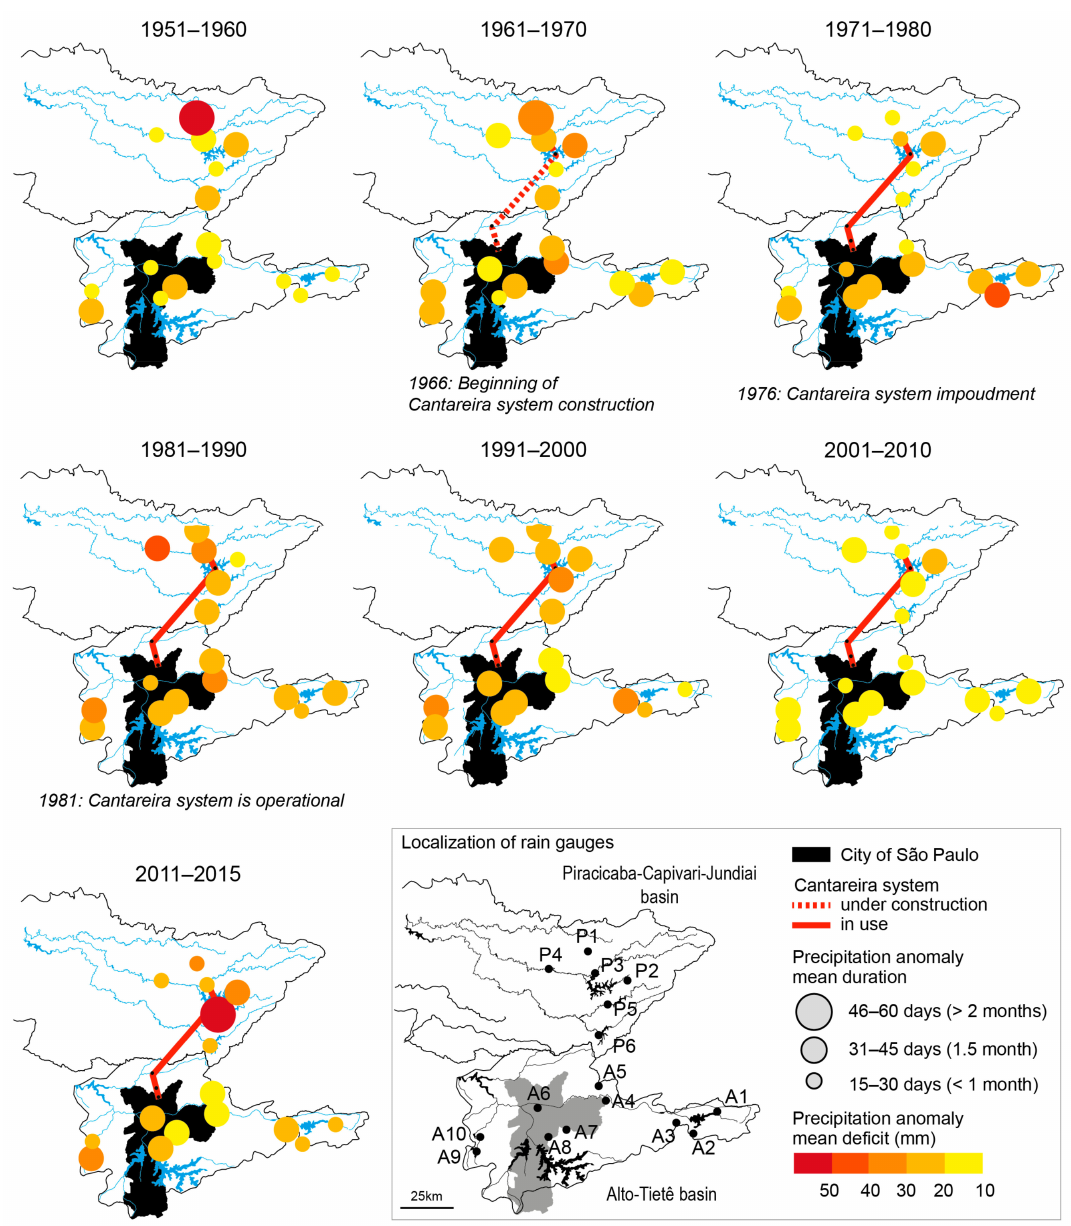
Figure 6. Mean duration (circles) and mean deficit (color gradient) of precipitation anomalies in the Alto-Tiet ê basin and the headwaters of the PCJ basin during the 1951–2015 period, averaged at a decadal